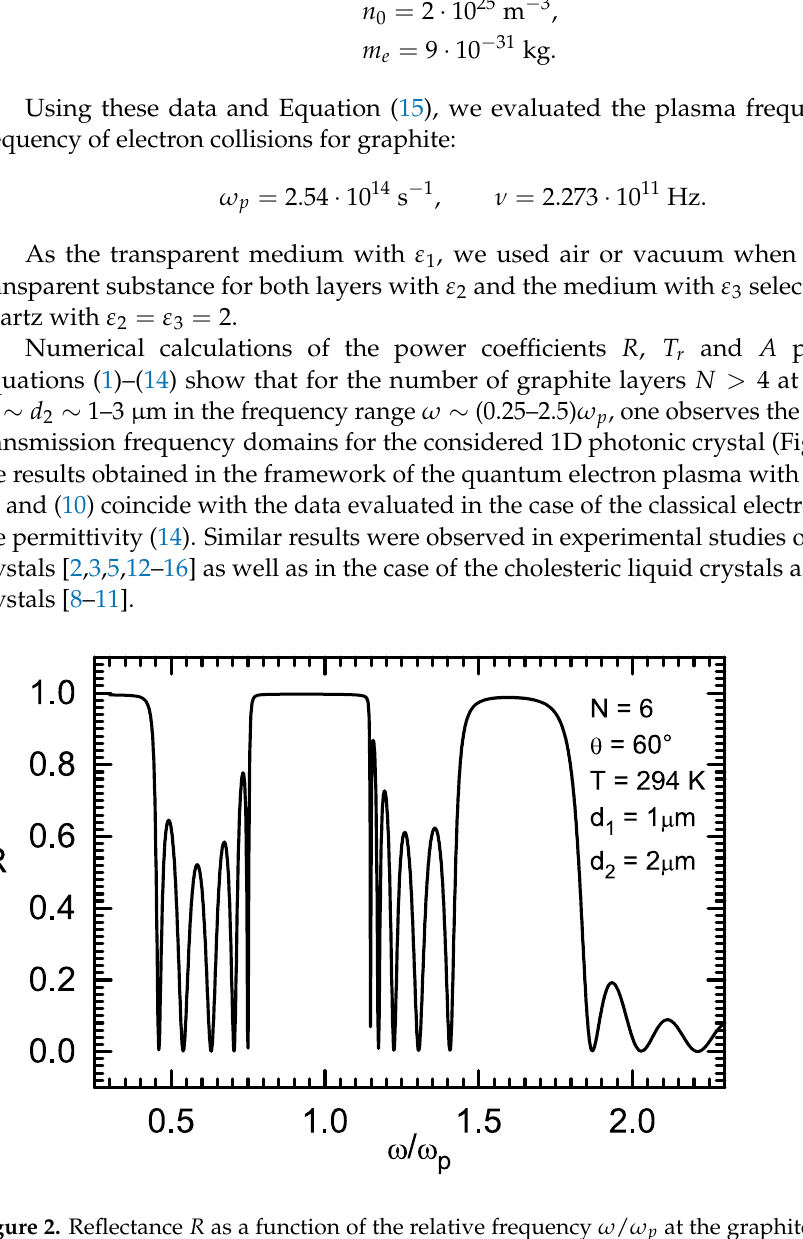
Figure 2. Reflectance R as a function of the relative frequency ω / ω p at the graphite layer number N = 6, incidence angle θ = 60 ◦ , temperature T = 294 K, graphite layer thickness d 1 = 1 µ m, and quartz layer thickness d 2 = 2 µ